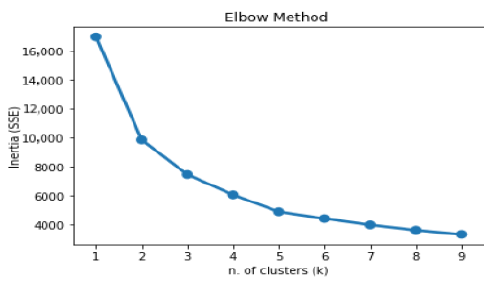
Figure 12. Elbow Plot for K-means clustering.